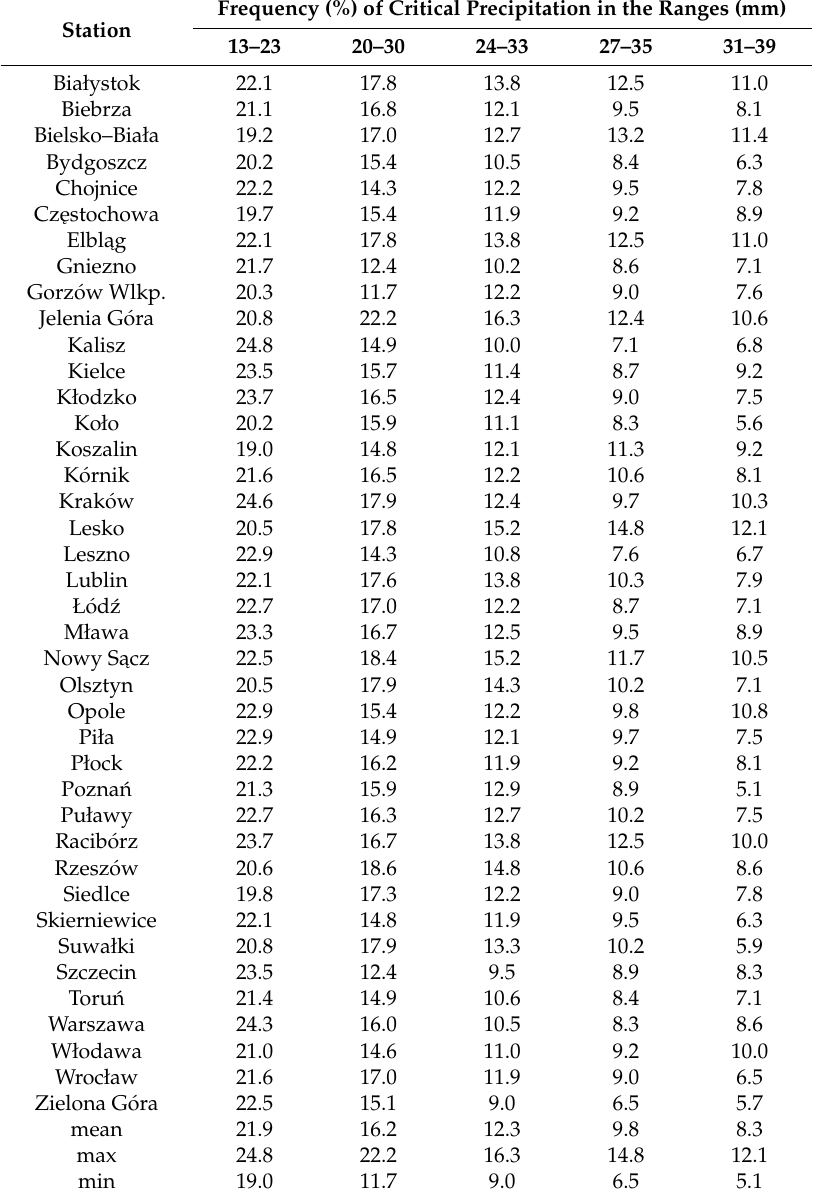
Table 3. Relative frequency of critical precipitation for the surface